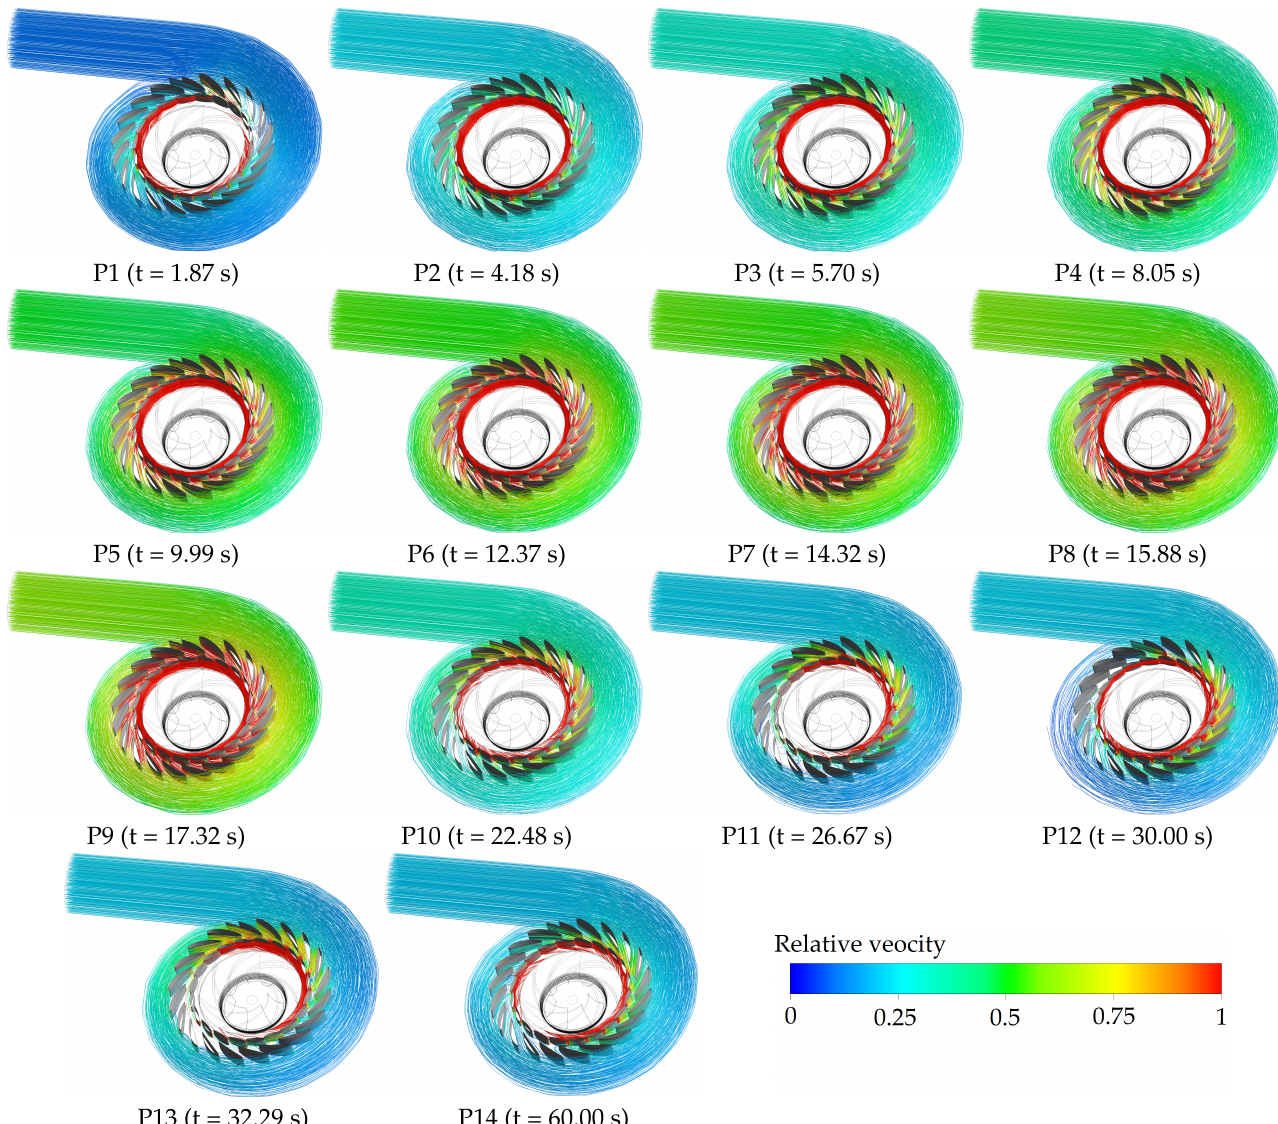
Figure 7. The flow velocity distributions of the pump-turbine unit during turbine start-up. The pressure distributions in the upper and lower side of the flow passage from stay vanes to draft tube at four typical moments (t = 1.87 s, t = 4.18 s, t = 22.48 s, t = 60.00 s) are displayed in Figure 8. The upper side of the flow passage includes the region of the stay vanes, guide vanes, upper chamber, and upper labyrinth seal, while the lower side includes the stay vanes, guide vanes, upper chamber, and upper labyrinth seal. In each subfigure, the upper side is on the left and the lower side is on the right. From Figure 8 it can be seen that the upper side at the beginning of the start-up process has the largest pressure. At this time, the discharge is low so that the pressure applied on the flow passage equals the static pressure of the water. With the guide vanes open, the flow rate increases. According to the Bernoulli principle, the pressure decreases with the rise of the flow velocity. However, at the time of 22.48 s, the pressure increases in the flow passage, which corresponds to the lowest discharge in the flow passage. The same phenomenon can also be seen in Figure 3. In Figure 3, the pressure in the spiral casing inlet increases at 20 s, which is caused by the water hammer. Figure 8 also indicates that the pressure before the guide vanes is much higher than that in the runner chamber, which is due to the small opening of the guide vanes. In addition, during turbine start-up, the pressure on the upper side of the